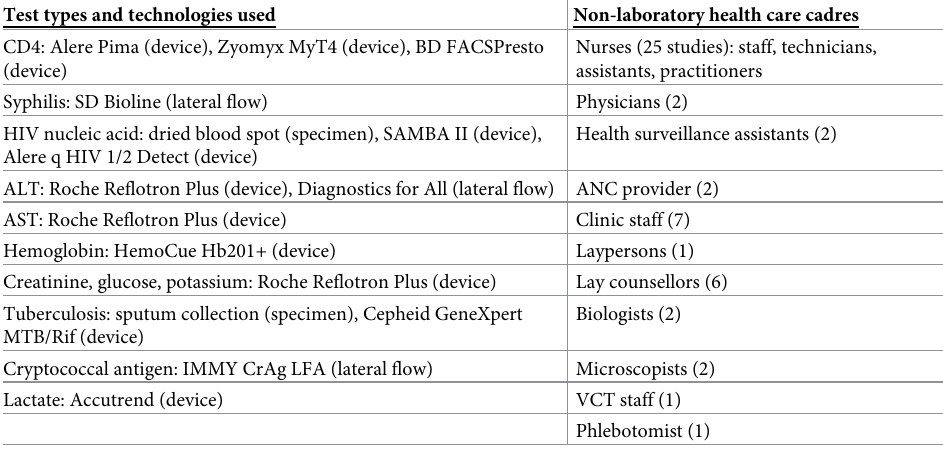
Table 2. Test types, technologies used, and non-laboratory health care cadres in included studies. Test types and technologies